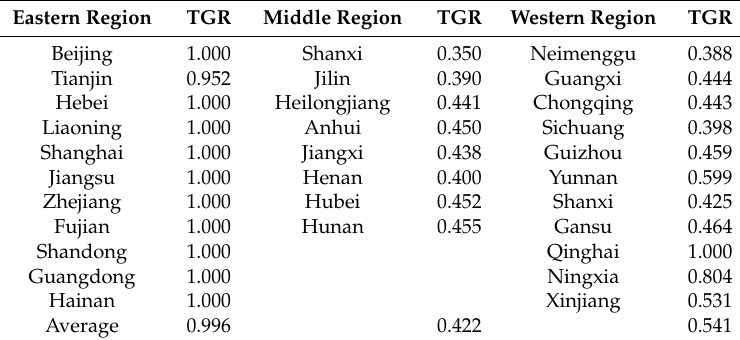
Table 4. Average technology gap ratio (TGR) of